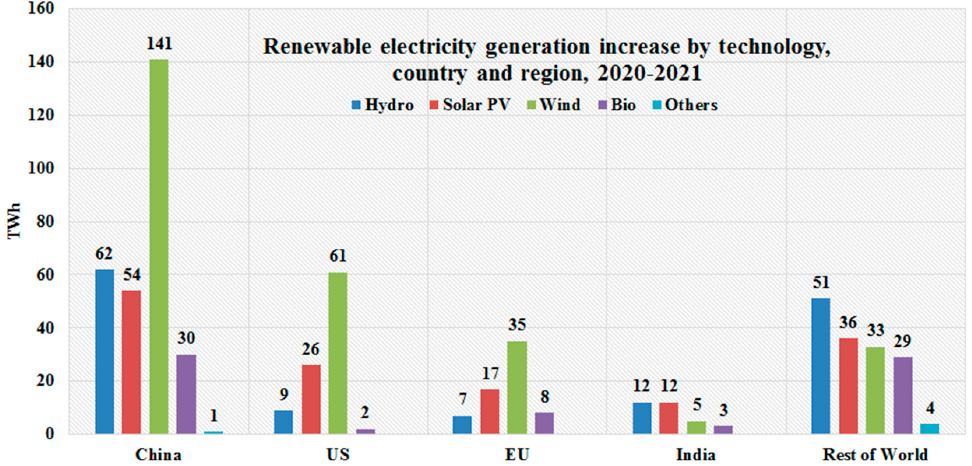
Figure 4. Global top countries in the world with renewable power capacities in 2020 (in TWh). Source: REN21 (Renewable Energy Policy Network for the 21st Century) [25].